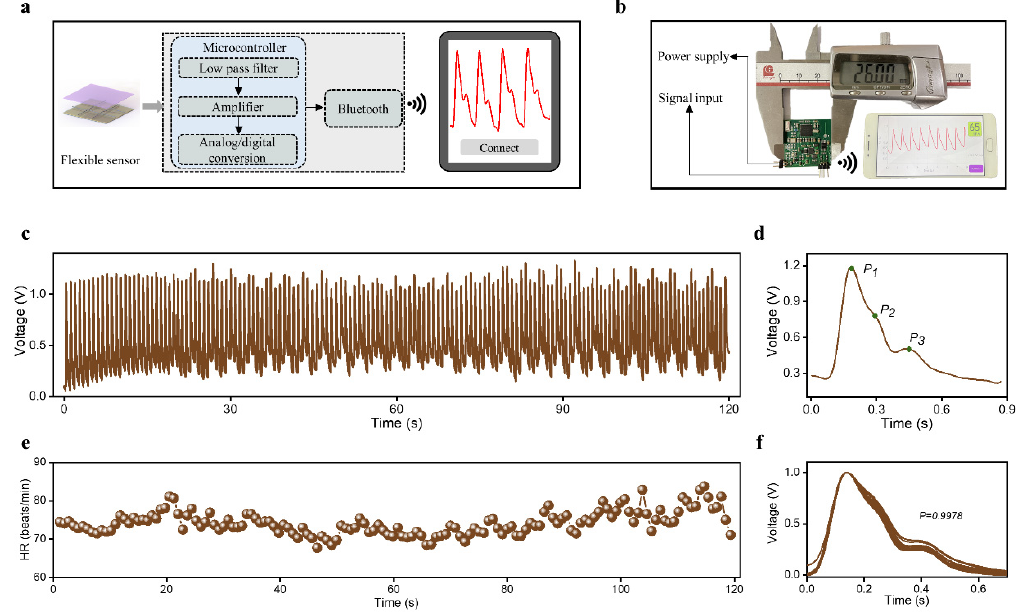
Figure 3. The developed monitoring system and human pulse wave monitoring: ( a ) schematic diagram of the pulse wave monitoring system, ( b ) optical images of the hardware circuit and mobile phone application terminal , ( c ) measured human pulse wave at wrist in 2 min, ( d ) one cycle of the pulse wave, ( e ) real-time HR calculated from the pulse wave, and ( f ) consistency of pulse signals in different cycles.